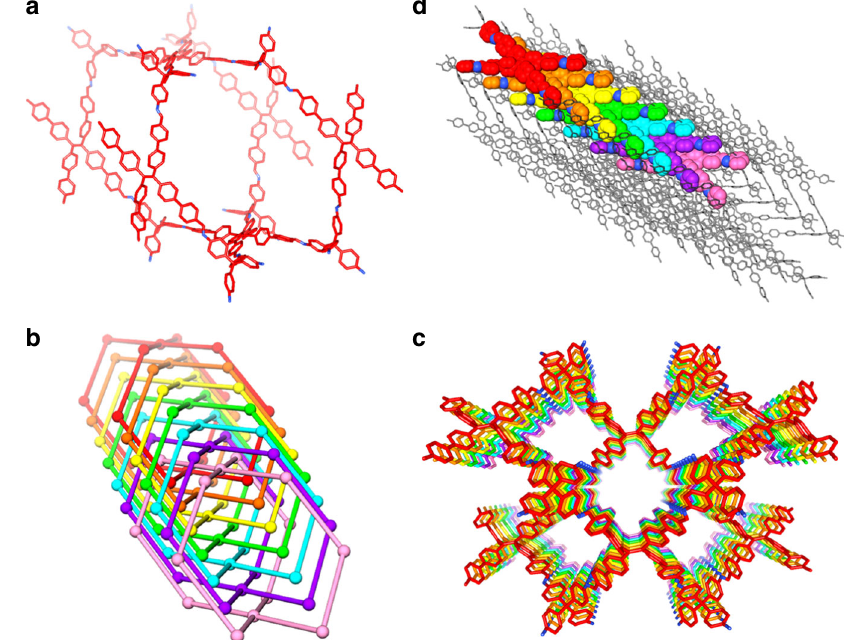
Fig. 3 Structural representations of 3D-TPE-COFs. a Single pts network; b seven-fold interpenetrated pts topology; c the porous structure of 3D-TPE-COF; d the stacking behavior of TPE molecules in framework. Hydrogen atoms are omitted